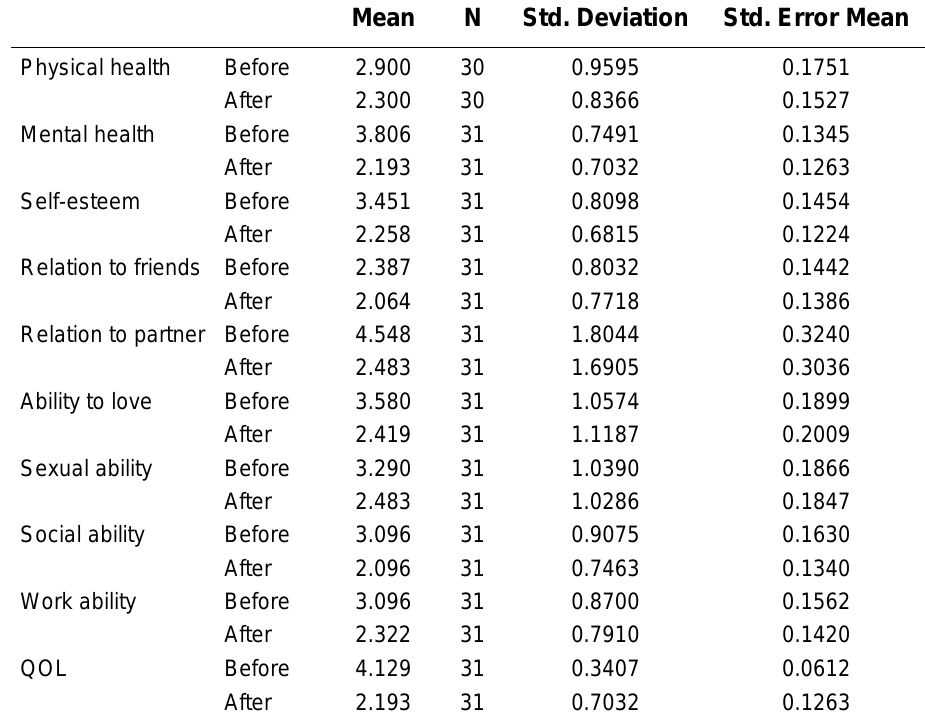
Study of 31 Patients where Therapy Changed their Ratings of Self-Evaluated QOL from Low to Not Low*